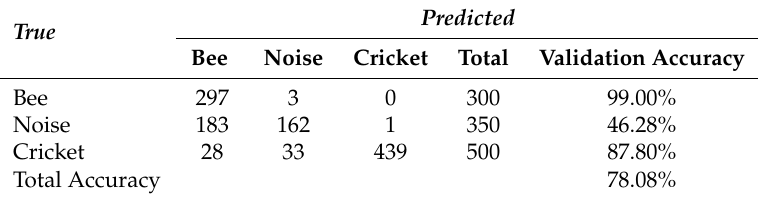
Table A7. Confusion matrix for ConvNet 2 with receptive field size n = 80 on BUZZ1 validation